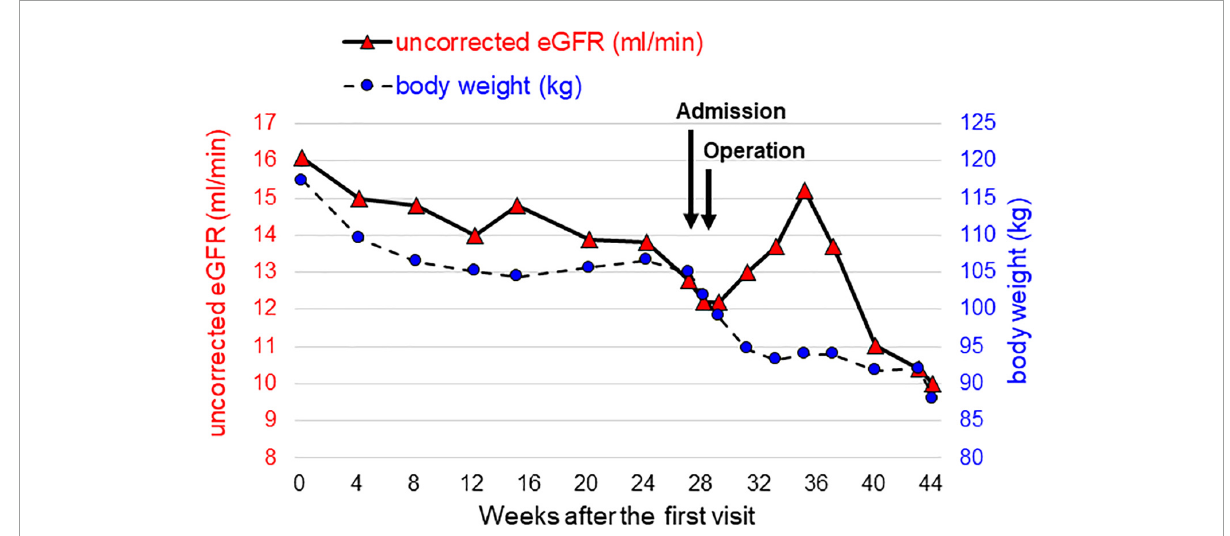
FIGURE1 Time courses of kidney function and body weight from the time of the initial visit to the introduction of peritoneal dialysis. Uncorrected eGFR, which reflects kidney function, is represented by red triangles on the left axis, and body weight is represented by blue circles on the right